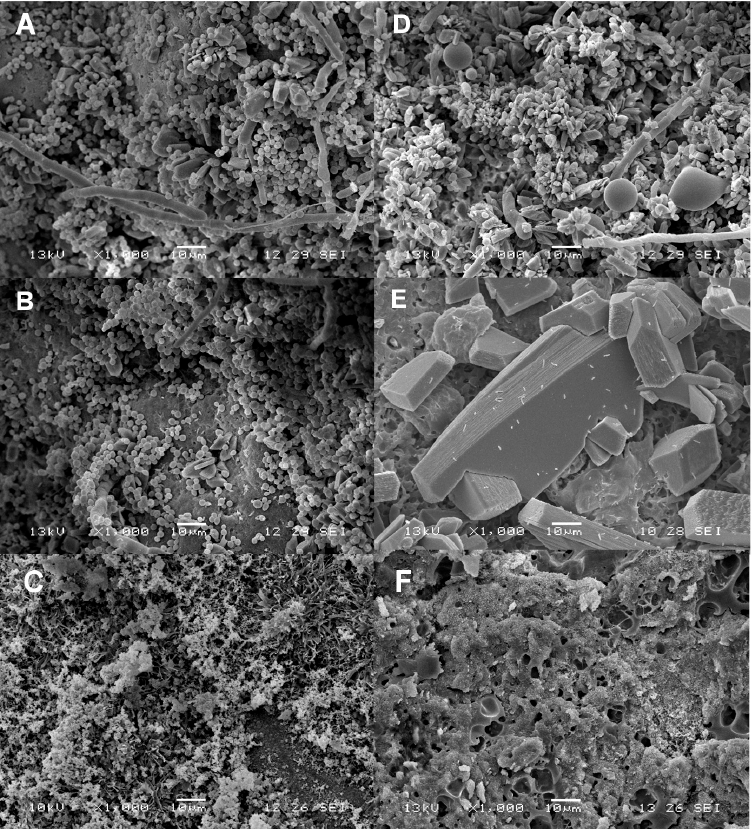
Figure 4. SEM micrographs of fresh cheese samples non-inoculated:control non-packaged ( A ); LDPE packaging ( B ); ChLA-TSA-SPI packaging( C ); Inoculated with L. monocytogenes control non-packaged ( D ); LDPE packaging ( E ) and ChLA-TSA-SPI packaging ( F